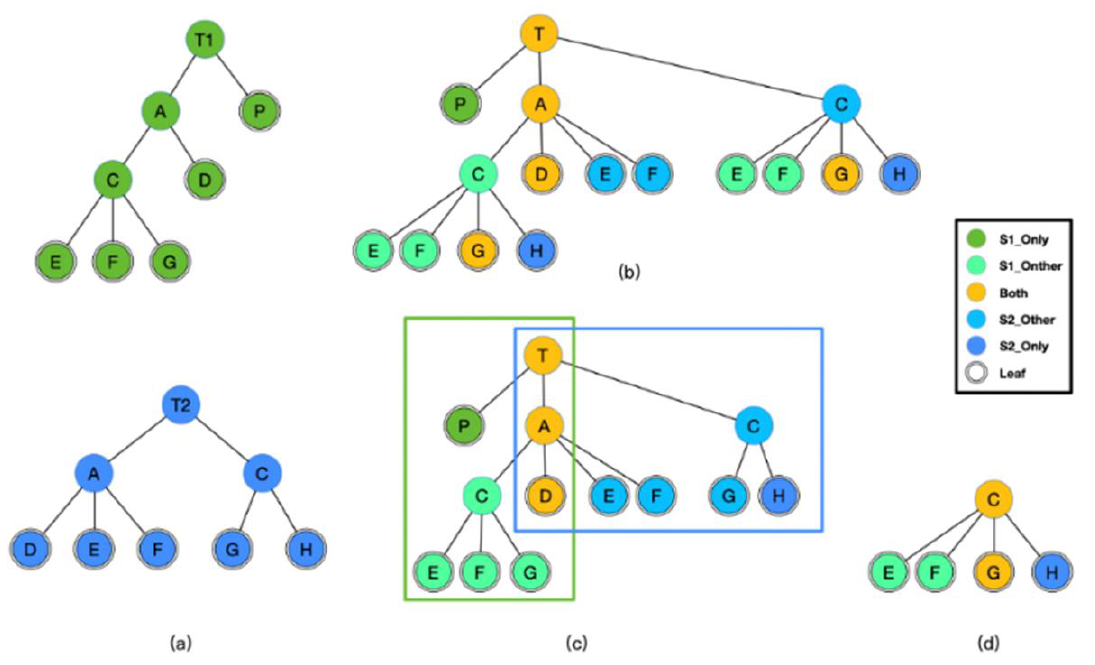
Figure 5. Construction of the union tree. ( a ) Two original trees. ( b ) A complete union tree with a large number of redundant structures. ( c ) A union tree after pruning. ( d ) Structure of pruned internal nodes in the union tree.